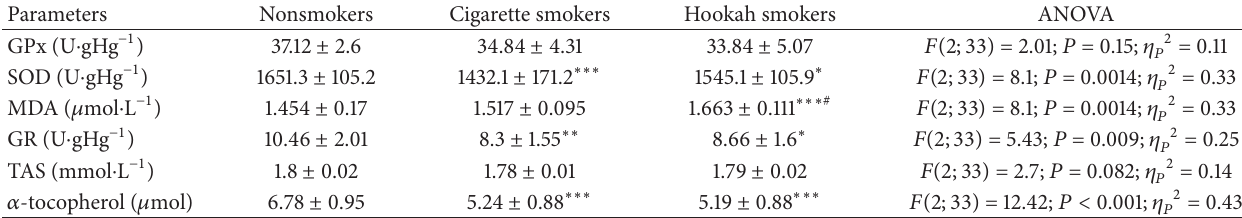
Table 2: Antioxidant concentrations before training (mean ± SD).